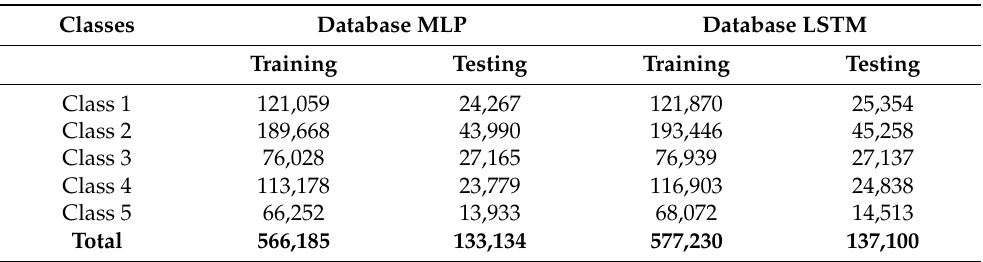
Table 2. The numerosity of frames in the training and testing MLP and LSTM sequence databases and their repartition in five